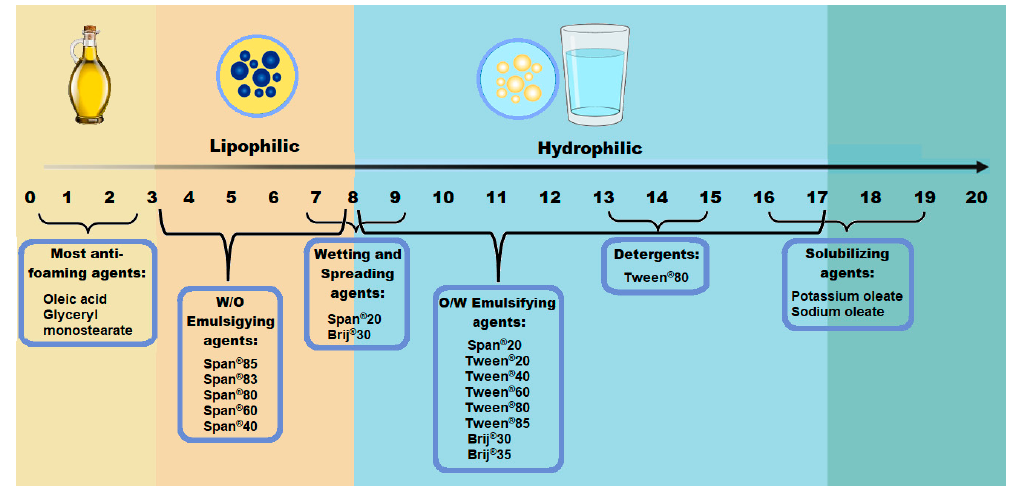
Figure 4 . Hydrophilic–Lipophilic Balance (HLB) Scale [42,43]. Figure 4. Hydrophilic–Lipophilic Balance (HLB) Scale